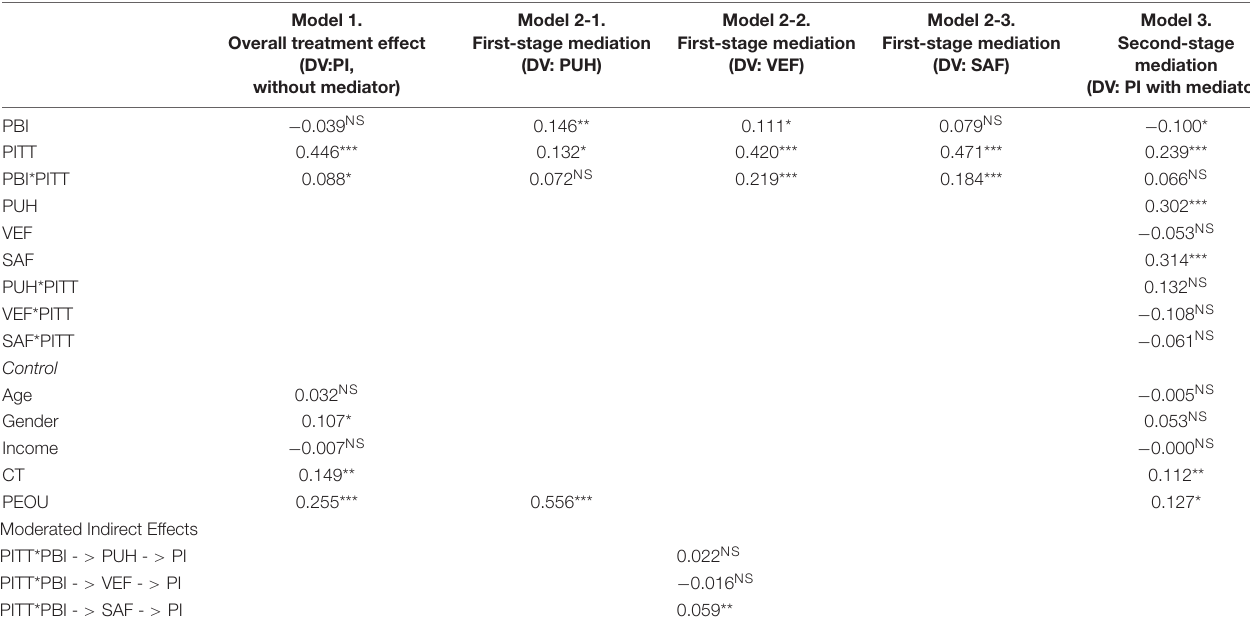
FIGURE 1 | PLS regression results for models without moderation. TABLE 5 | PLS regression results for the moderated mediation